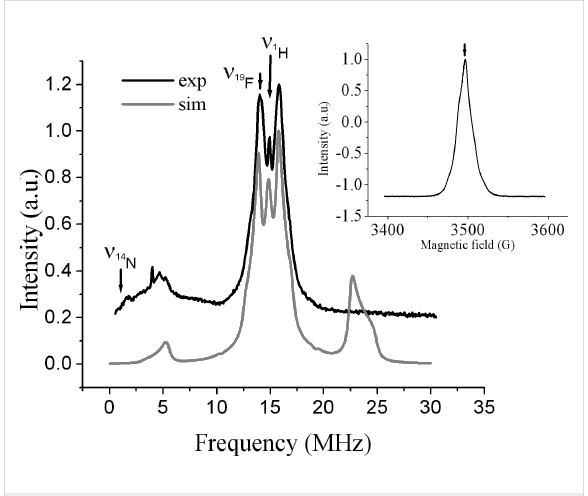
Figure 7: Experimental and simulated Davies ENDOR spectrum after the Ga-promoted reaction of azide 6 recorded at 50 K. The inset shows the field-swept EPR spectrum with an arrow indicating the magnetic field position of the ENDOR